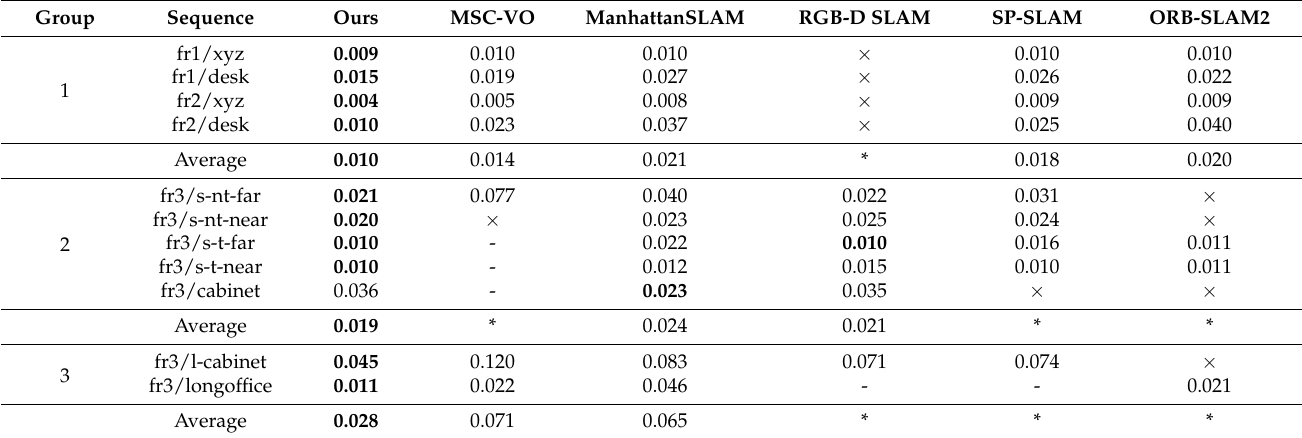
Table 4. Comparison of ATE RMSE (M) for TUM RGB-D sequence.